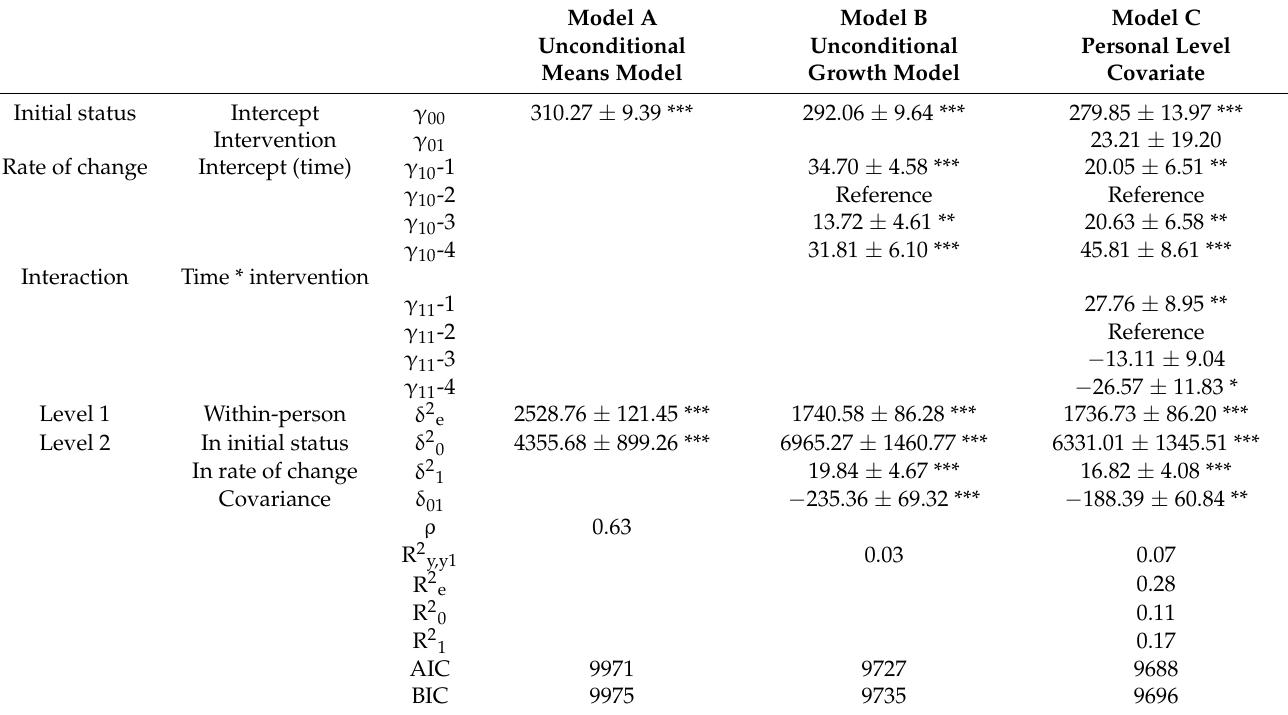
Table 4. Mixed model analyses of variations in light-intensity physical